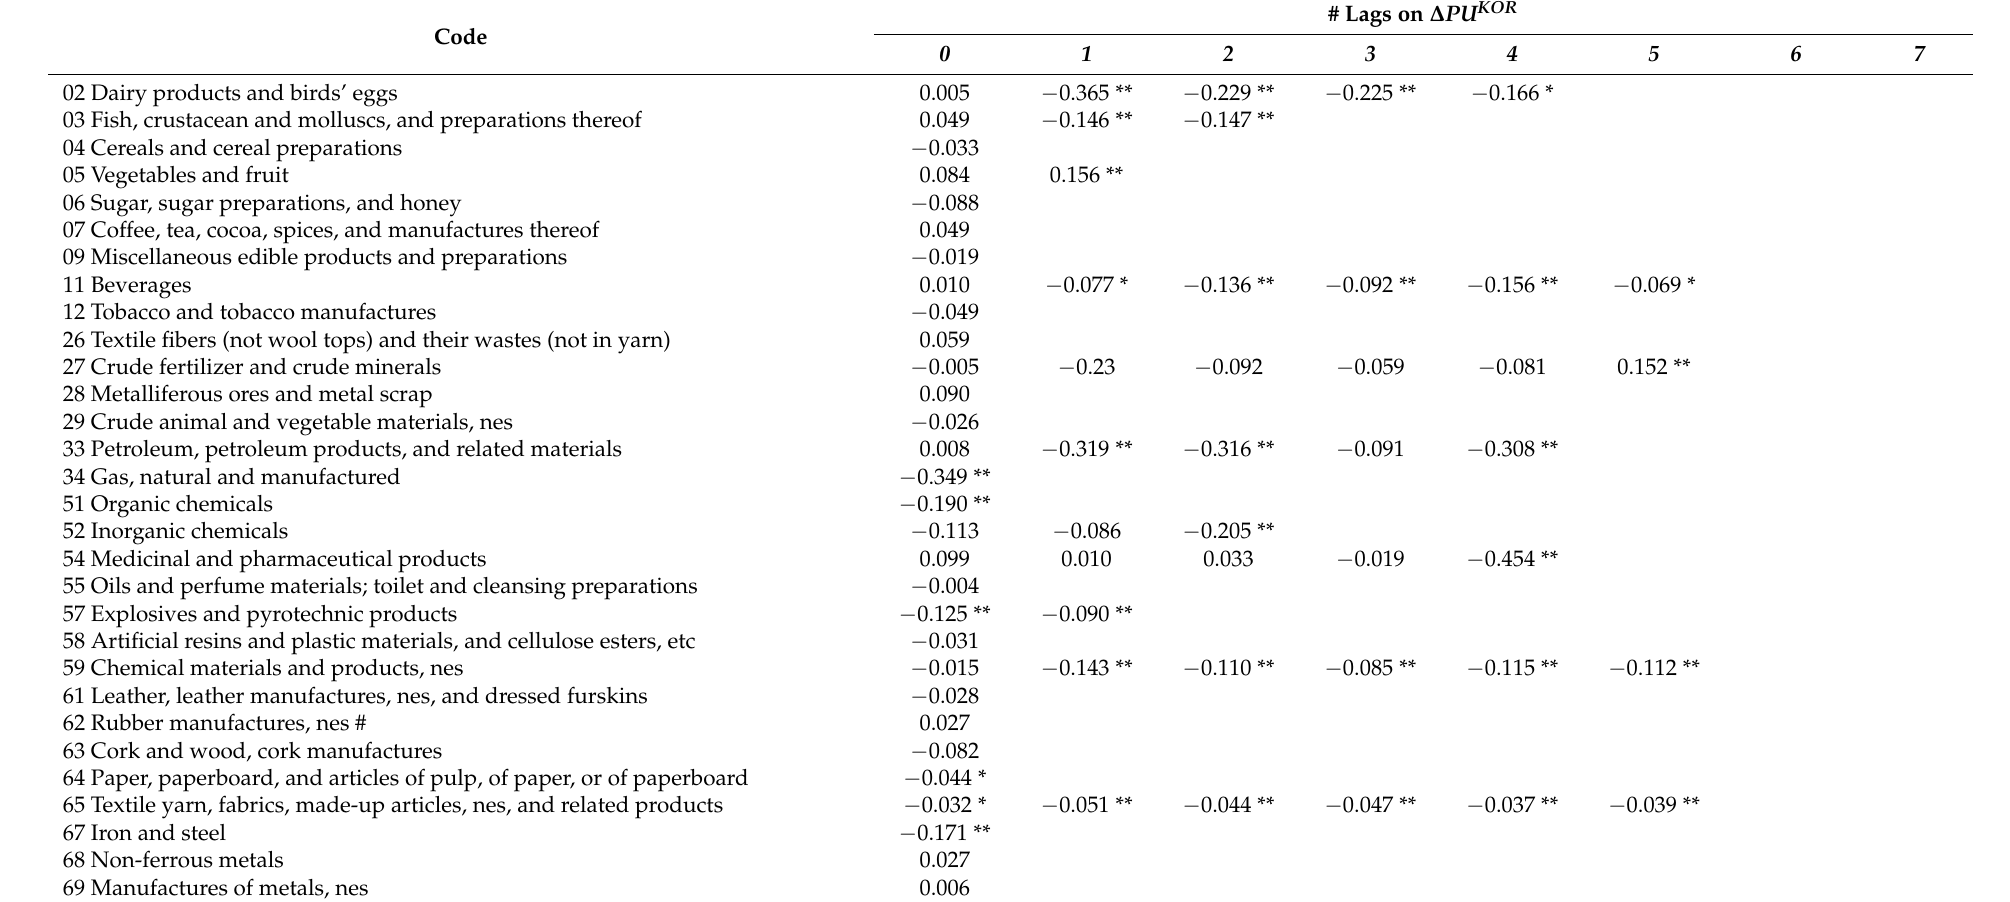
Table 5. Short-run coefficient estimates of Korea economic policy uncertainty on U.S. imports from